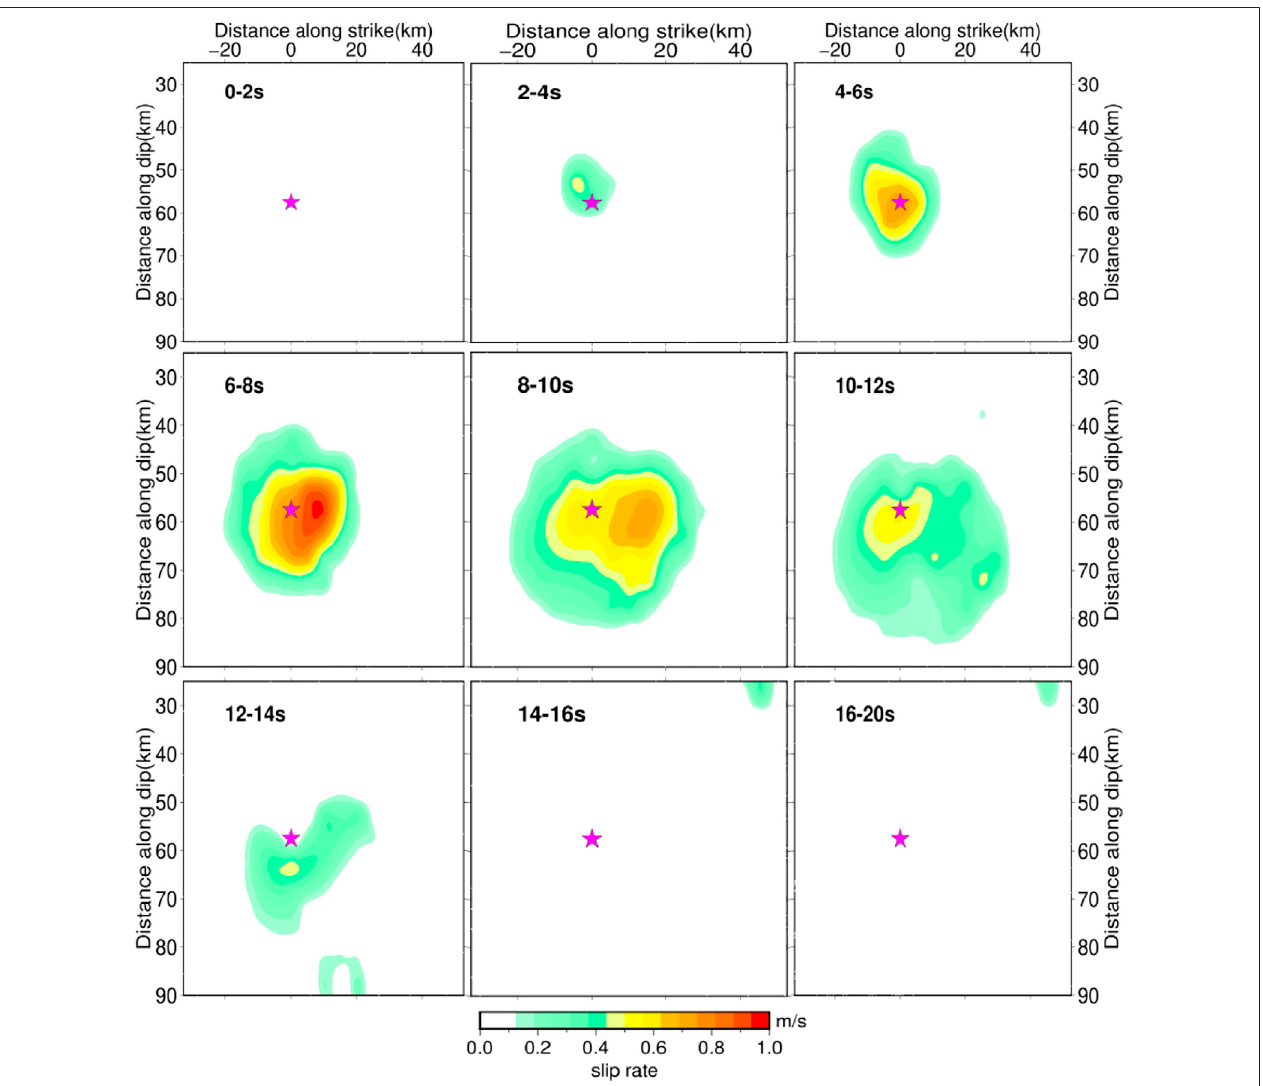
FIGURE 10 | Snapshots of the slip rate for the 2020 Oaxaca earthquake with a time interval of 2 s, most of the moment was released at 14 s. The magenta star denotes the epicenter.